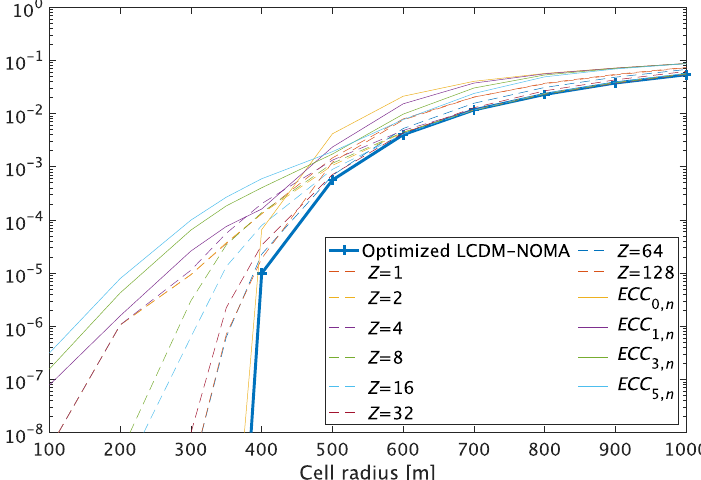
Figure 11. Adaptive parameter optimization in LCDM-NOMA. (The thick solid line is the adaptive parameter optimized LCDM-NOMA. The dashed lines with Z values are based on ECC τ 7 while using the specified Z values for the threshold levels. The solid lines with ECC i , n employ only ACK and NACK in the